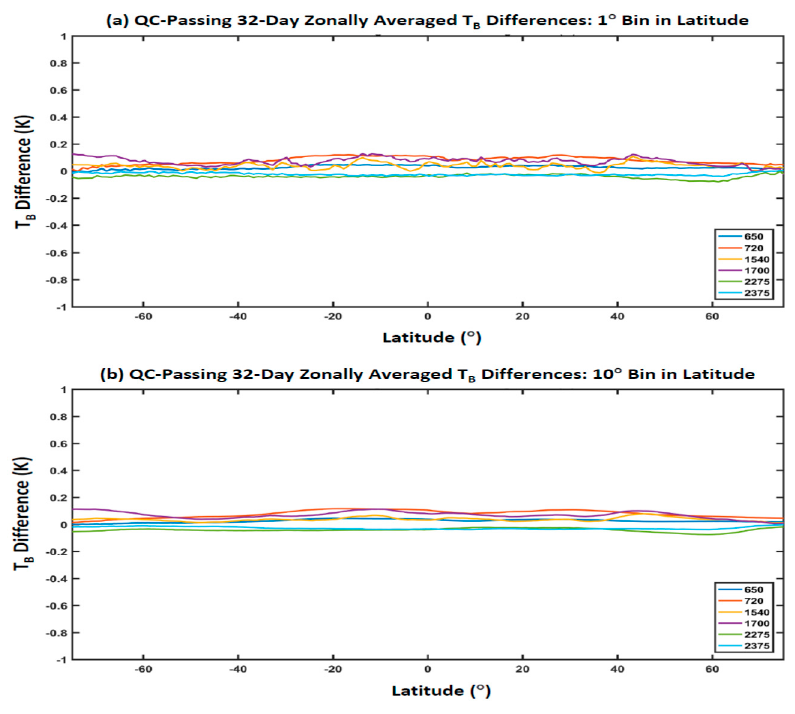
Figure 12. The zonal mean of ∆𝑂 (cid:2901)(cid:2887)(cid:2871)(cid:2870)(cid:3005),(cid:3017)(cid:3042)(cid:3114)(cid:3041)(cid:3047)(cid:3015)(cid:2870)(cid:2868)(cid:2879)(cid:3020)(cid:3015)(cid:3017)(cid:3017) (cid:3364)(cid:3364)(cid:3364)(cid:3364)(cid:3364)(cid:3364)(cid:3364)(cid:3364)(cid:3364)(cid:3364)(cid:3364)(cid:3364)(cid:3364)(cid:3364)(cid:3364)(cid:3364)(cid:3364)(𝑖, 𝑗) from − 75 ° S to 75 ° N at six upper sounding chan- nels for SNPP and NOAA-20 CrIS, where the data cover the period from 27 September to 28 October 2019, and the selected six channels are 2275 and 2375 cm − 1 in the SW band, 1540 and 1700 cm − 1 in the MW band, and 650 and 720 cm − 1 in the LW band. ( a ) Zonal mean per bin of 1 ° latitude. ( b ) Zonal mean per bin of 10 ° latitude.